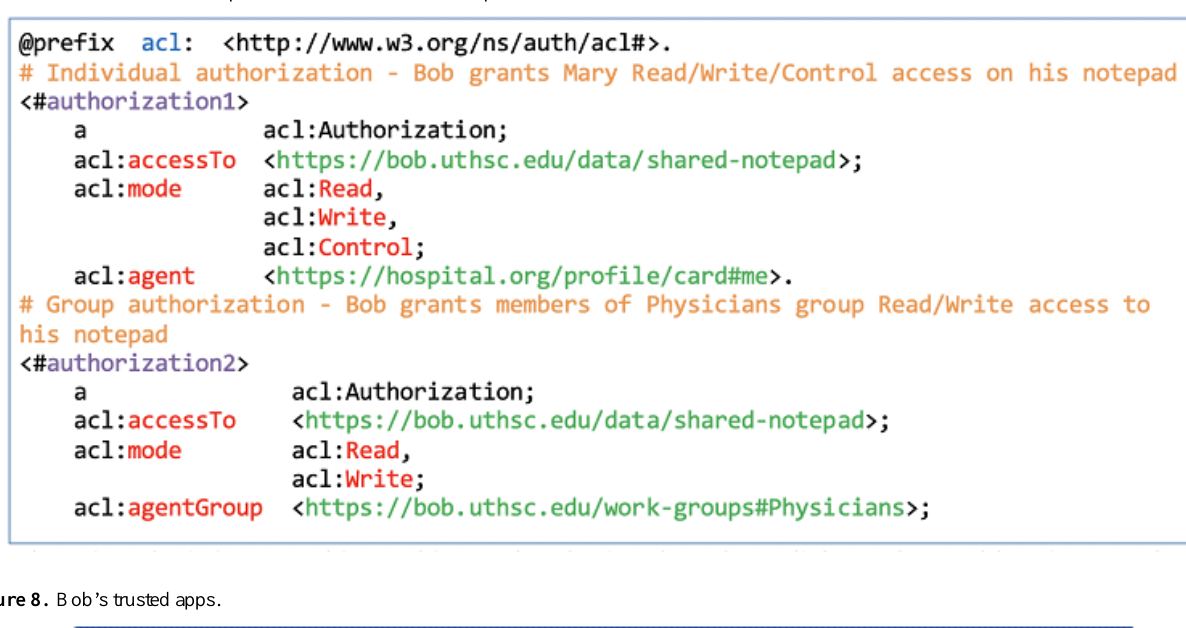
Figure 7. Individual and Group authorizations to Bob’s notepad.